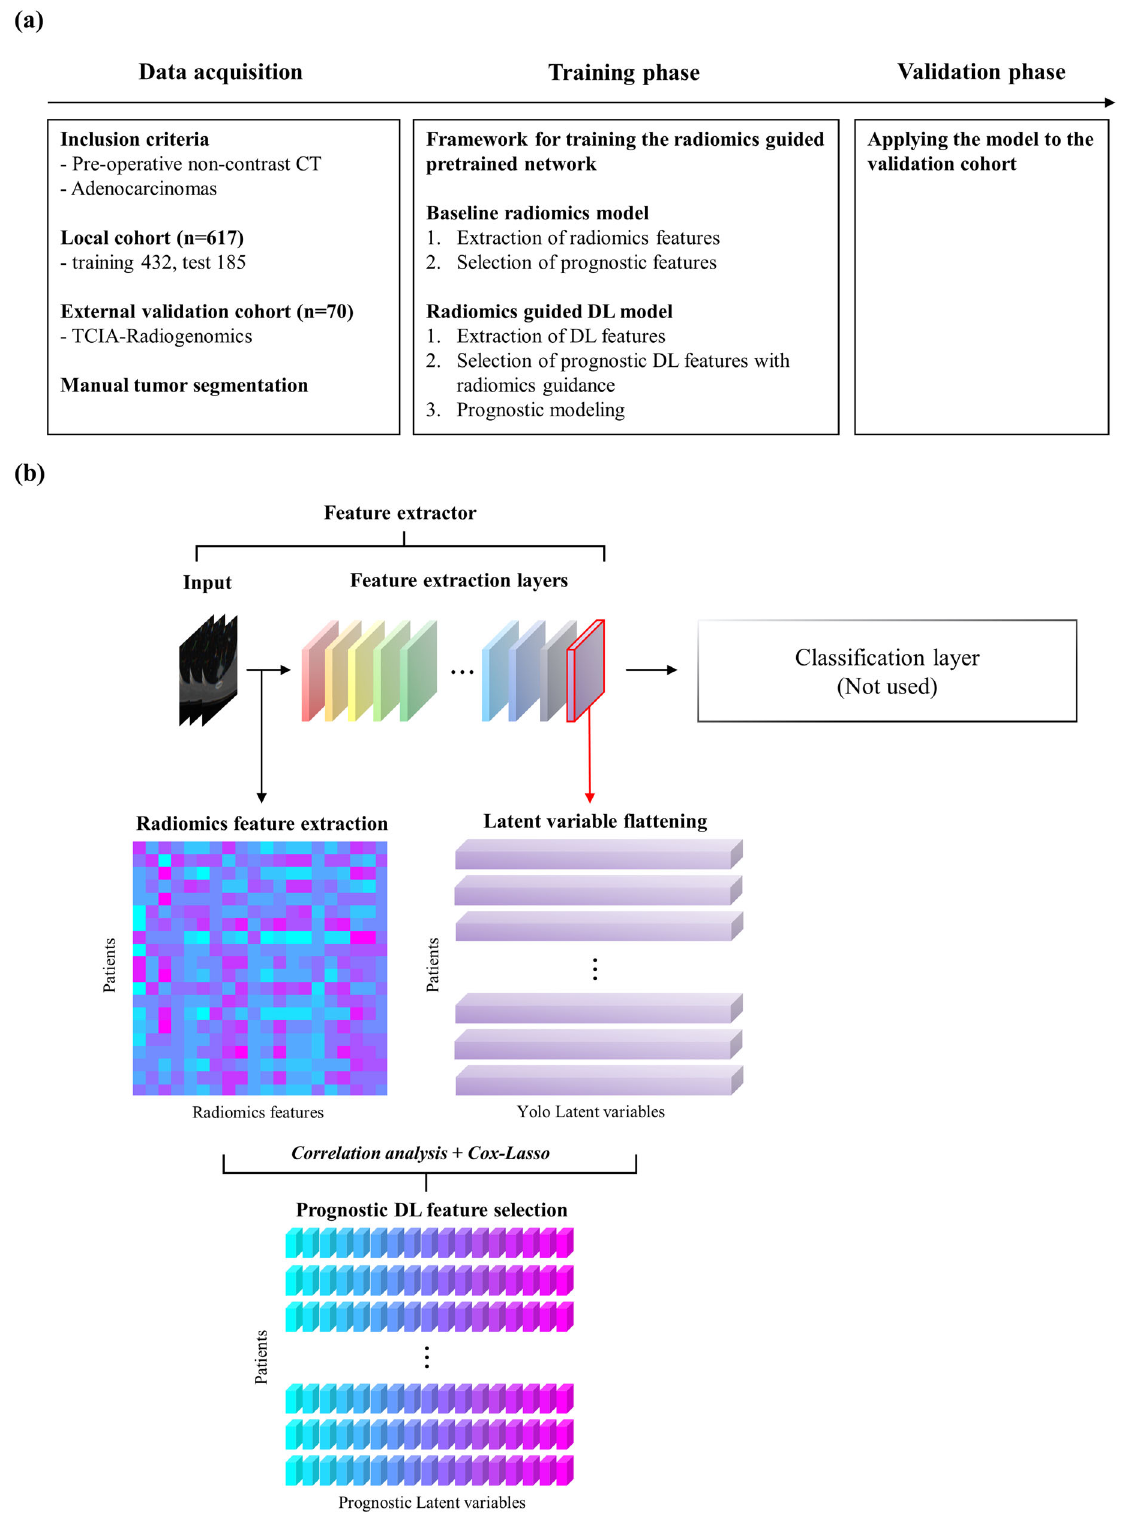
Fig. 1 Overall work fl ow of the study. ( a ) Three major procedures used in this study. ( b ) Graphical description of DL feature selection guided by radiomics used for